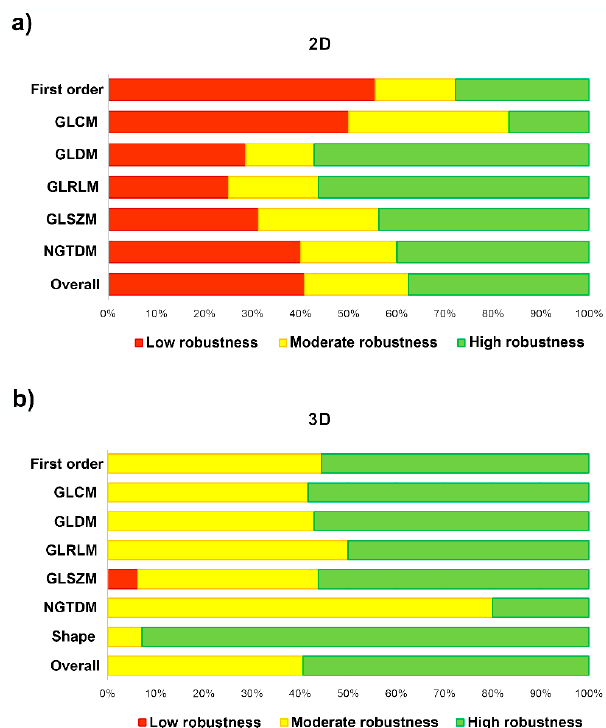
Figure 6. Bar-chart plots show the degree of feature robustness: ( a ) 2D tumor segmentation; and ( b ) 3D tumor segmentation.